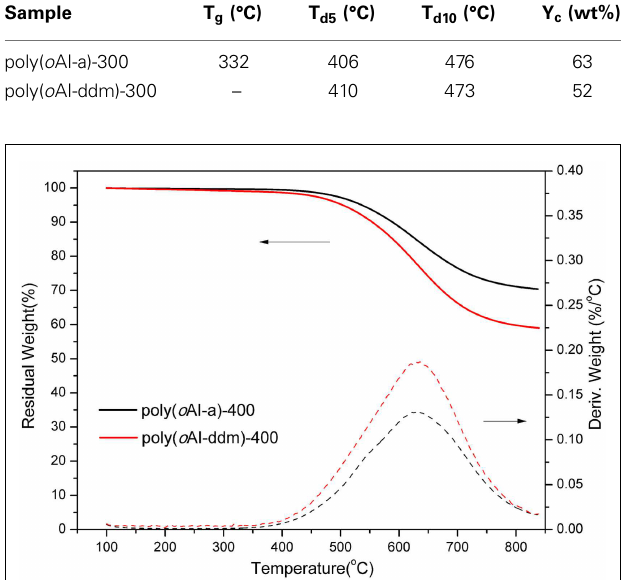
THERMAL PROPERTIES OF POLYBENZOXAZOLE THERMOSETS The thermal stability of PBO thermosets poly( o AI-a)-400 and poly( o AI-ddm)-400 has also been studied by TGA as shown in Figure13 .The5and10%weight-losstemperatures(T d5 andT d10 ) for poly( o AI-a)-400 are 536 and 589°C,respectively. For poly( o AI- ddm)-400, the T d5 and T d10 are 503 and 555°C, respectively. The maxima of weight-loss rates for poly( o AI-a)-400 and poly( o AI- ddm)-400 are as high as 633 and 636°C, respectively. Besides, the char yield for poly( o AI-a)-400 and poly( o AI-ddm)-400 are as high as 71 and 60%, respectively. The data demonstrate extremely high thermal stability of both monomer and main-chain